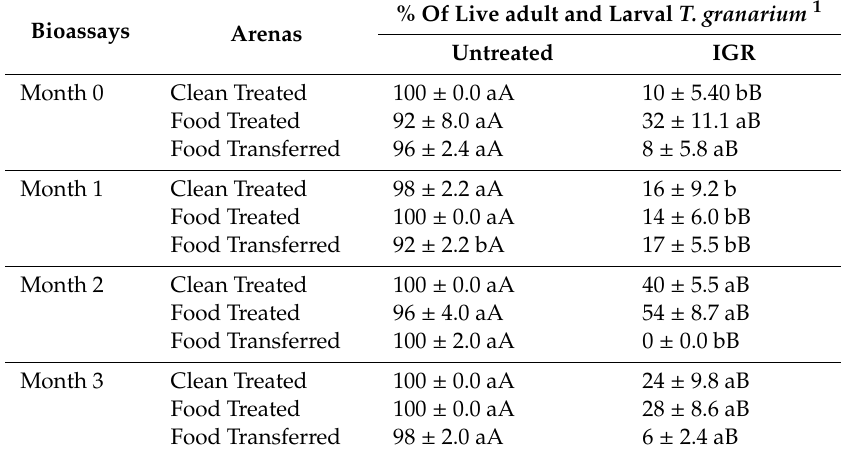
Table 10. Percentage of live adult T. granarium (means ± SE) emerging from the exposed larvae, plus live larvae, on the clean treated arenas with new food, the food-treated arenas with replaced food, and the untreated arenas with transferred treated food. Insecticide treatment as previously described